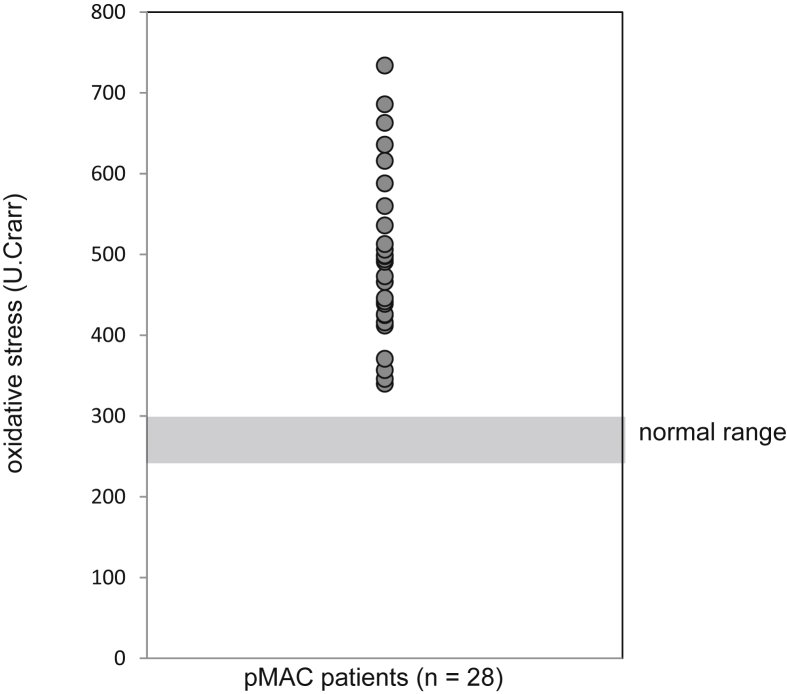
These levels exceeded the upper limit of the normal reference value. pMAC: pulmonary Mycobacterium avium complex; U.Carr: Carratelli Units.